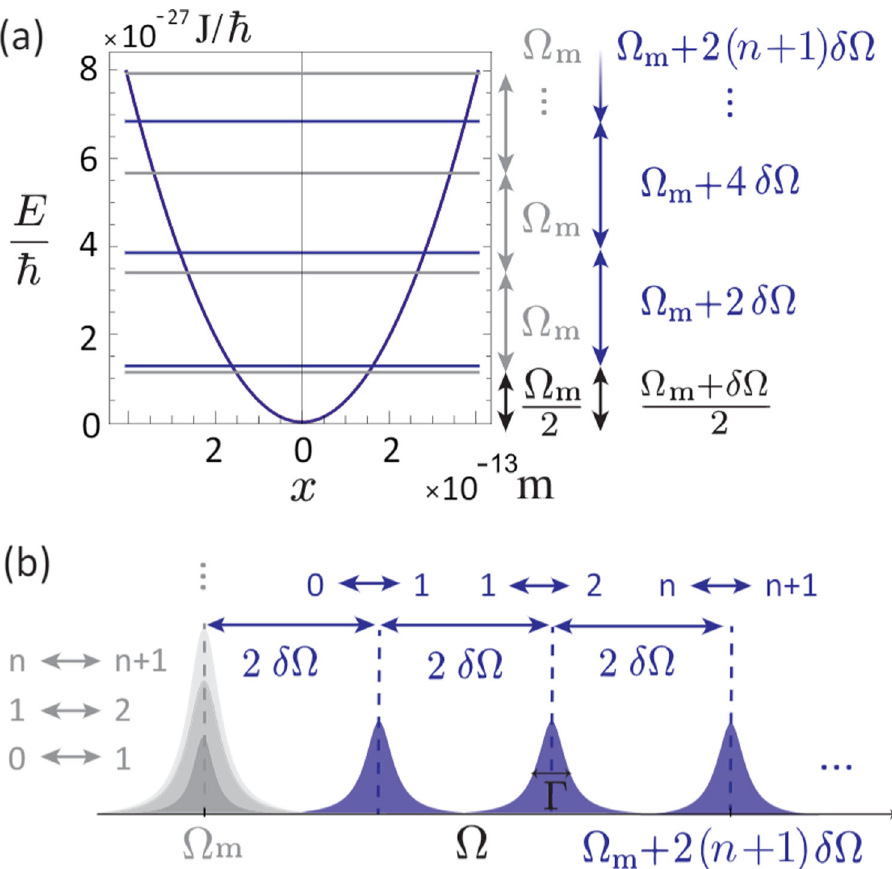
Fig. 3 Nondegenerate spectrum. a Energy spectrum (analytical solutions) for R = 0.5 μ m, d = 10 nm of a linear (gray) and nonlinear (blue) resonator, with energy shifts enlarged by a factor 10 8 to facilitate visual representation. b Illustration of the corresponding single-phonon transition frequencies. The harmonic oscillator features only a single resonance at Ω m (gray); the anharmonic oscillator (blue) exhibits degenerate spectral features at Ω [ n ] = Ω μ + ( n + 1) δ Ω